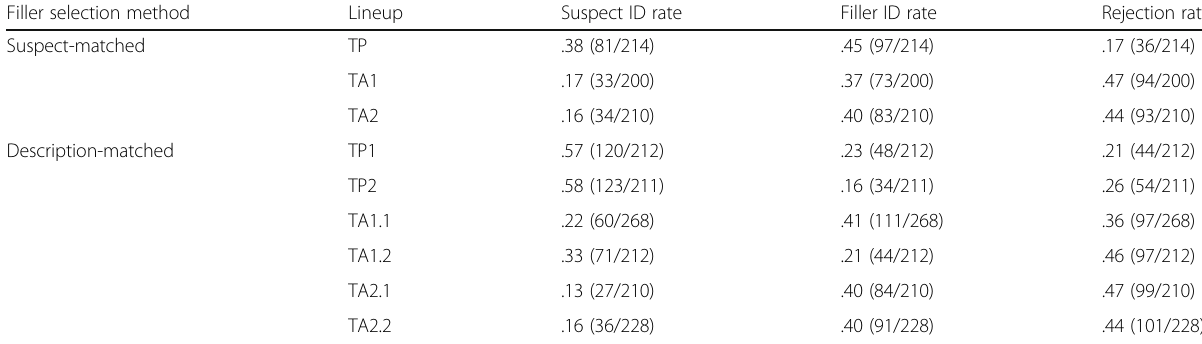
Table 4 Number of identifications and rejections from Experiment 2 Filler selection